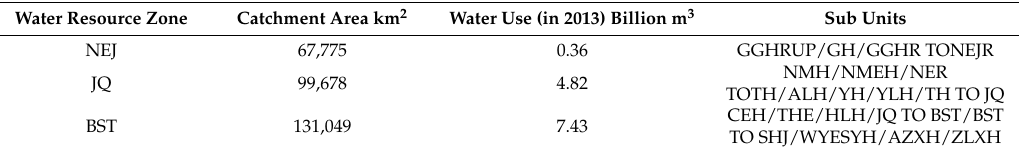
Table A2. Basic information about water resource